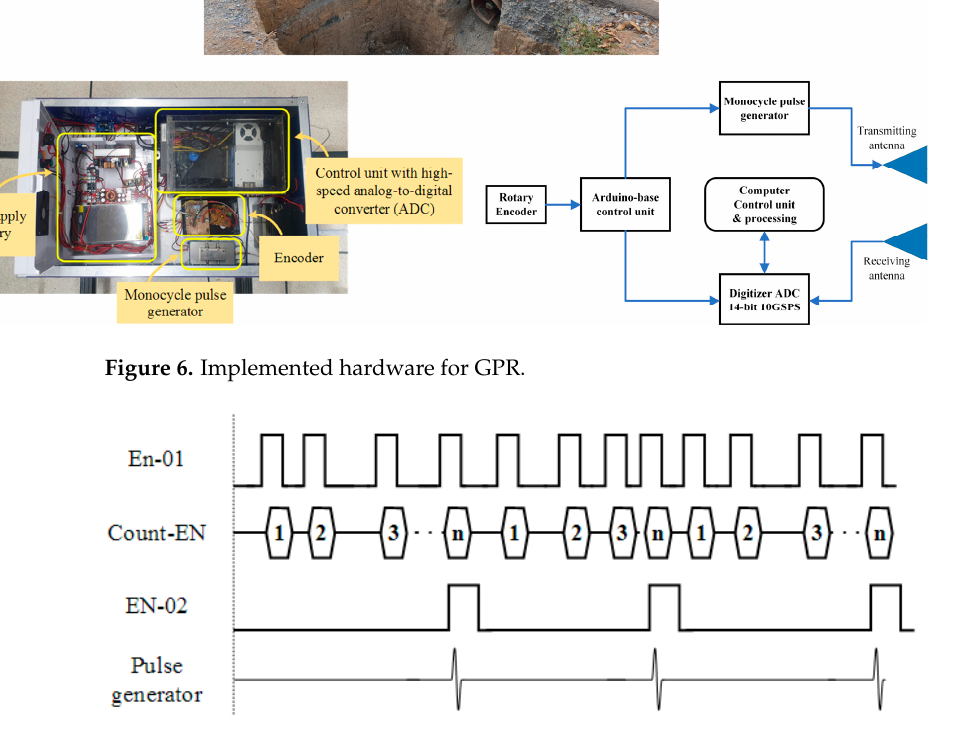
Figure 7. Timing diagram of the control unit.